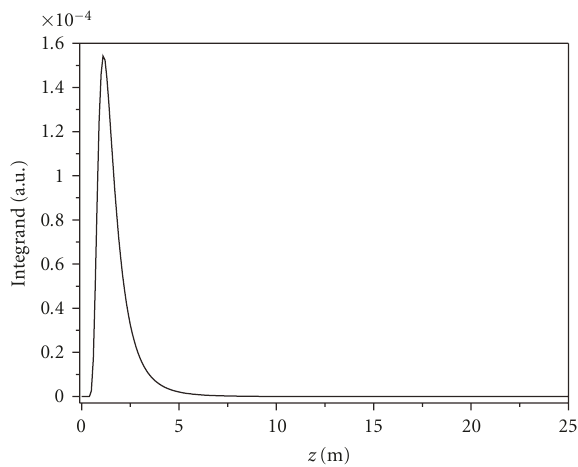
Figure 1: Plot of the integrand appearing in (46) as a function of z for f m = 0 and k (cid:6) = 0 . 201m − 1 , k f s = 0 . 459m − 1 , (cid:13) θ 2 (cid:14) = 0 . 036, r rec = 0 . 2m, r 0 = 0 . 025m, θ FOV = 0 .